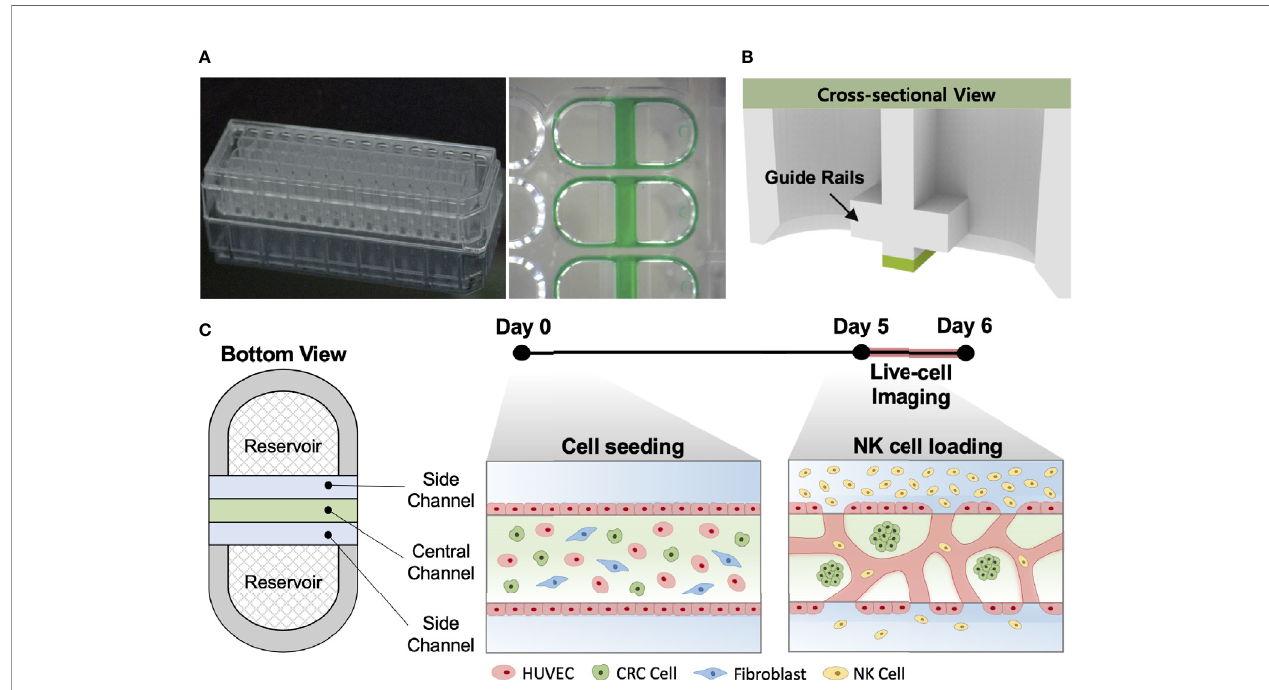
FIGURE 1 | In vitro tumor vasculature model on the injection-molded micro fl uidic platform. (A) Photograph of the injection-molded micro fl uidic platform. (B) Illustration of cross-sectional view of hydrogel patterning on the platform. The platform is composed of 3 parallel fl uid guide rails, and rapid and robust fl uid patterning driven by capillary forces enables high-throughput experiments. (C) Cell con fi guration in tbe tumor vasculature model and experiment time from cell seeding (Day 0) to live-cell imaging (Day 5-6). Perfusable blood vessel networks with CRC cell clusters can be formed within 5 days. To demonstrate the capability of this model, primary NK cells were introduced into the vascular network, and their migration, extravasation, and killing were monitored by live-cell imaging. Scale bar =